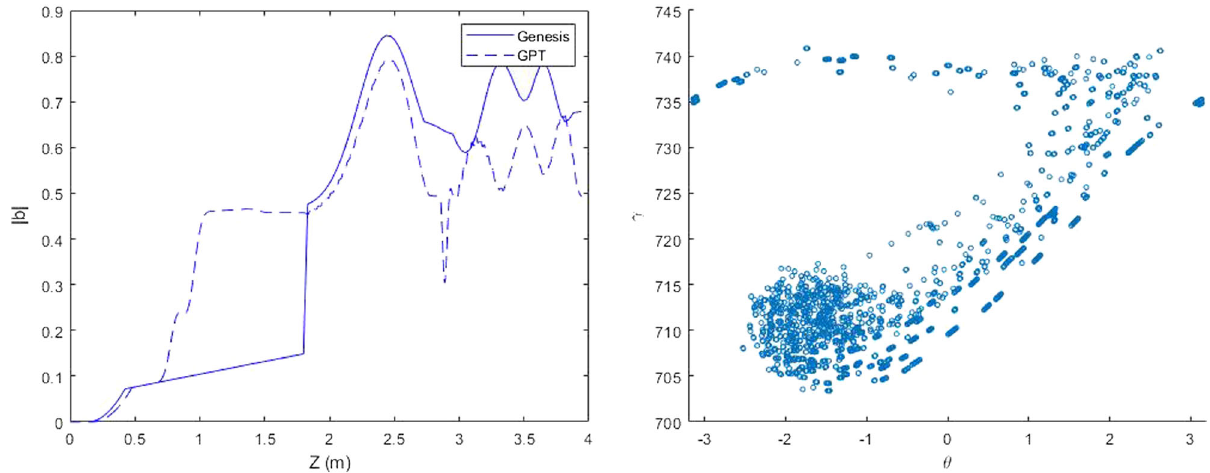
FIG. 6. Particle bunching and phase space at Z ¼ 2 . 8 m (after first undulator) for the TESSA